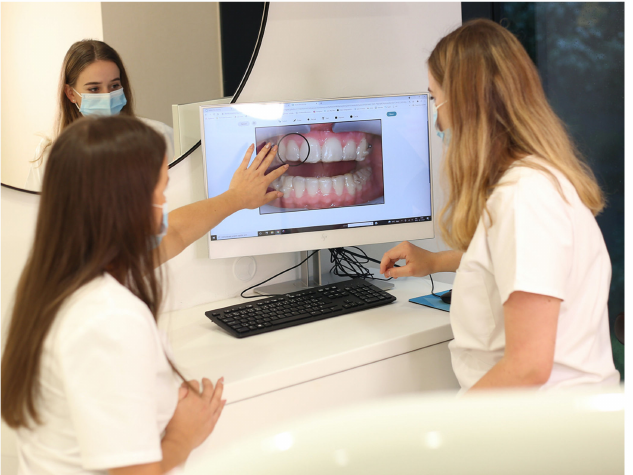
Figure 3. Dental assistants/nurses visually communicate problems with the patient represented in the black circle using DM scan exports. AI pre-processing identifies the severity of the problem, and nurses fix the issue(s) by managing patient communication/education; otherwise, doctors are alerted as